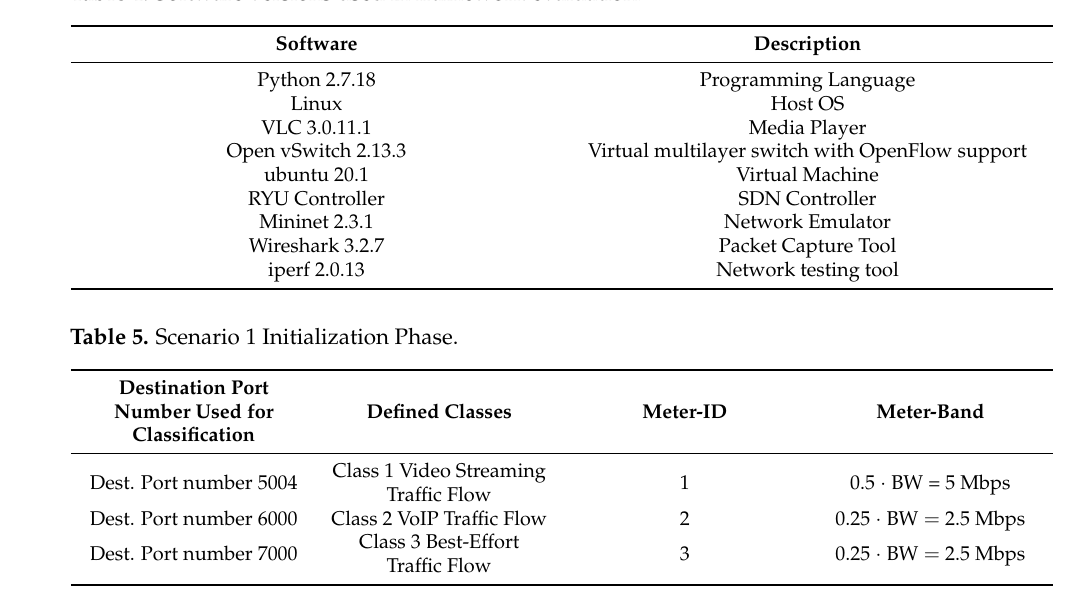
Table 4. Software versions used in framework evaluation.